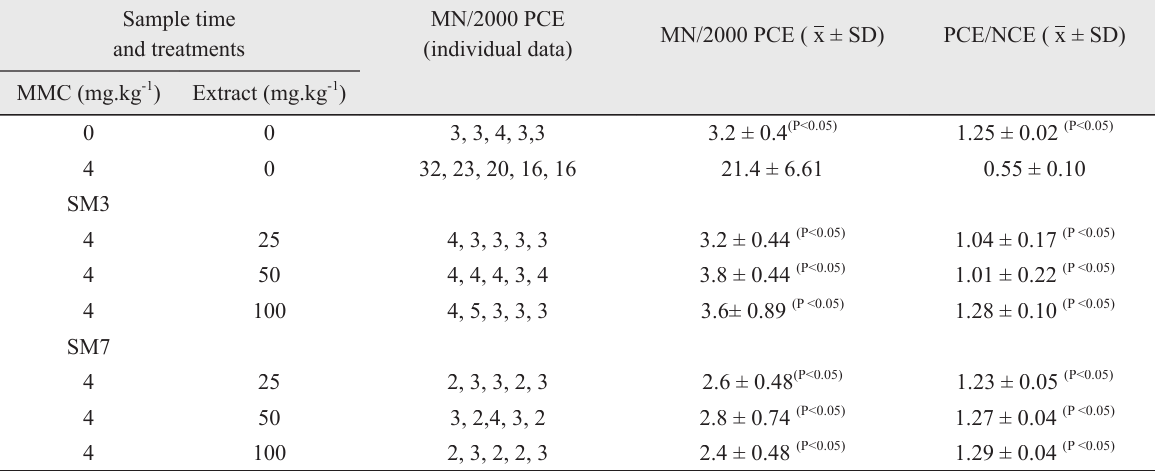
Frequencies of MNPCE and PCE/NCE ratio in bone marrow cells of mice treated with Solanum paniculatum SM3 or SM7 fractions and co-treated with mitomycin C (MMC). Sample